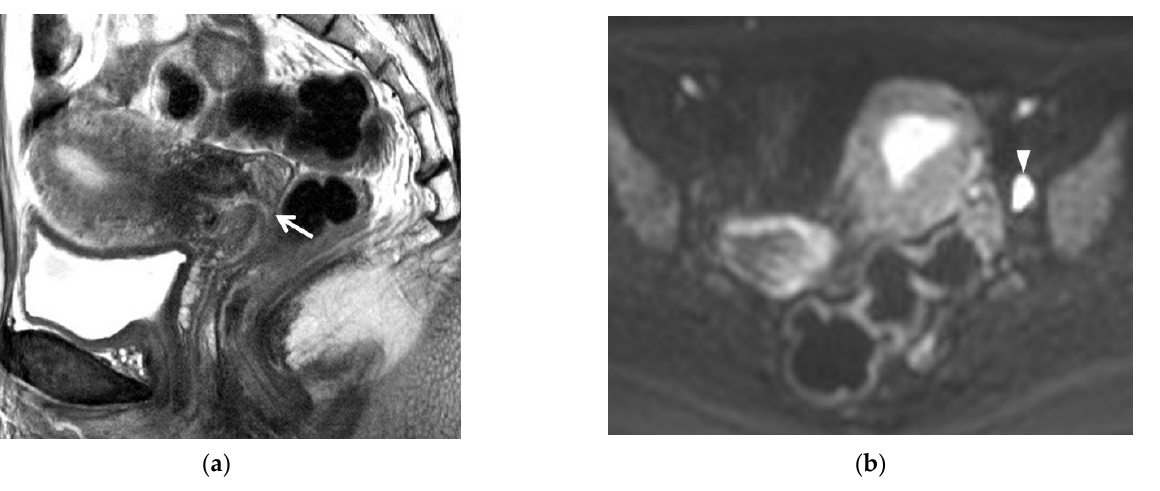
Figure 1. A 45-year-old woman with IB1 cervical cancer: ( a ) the IB1 cervical cancer in the patient undergoing a cone biopsy was not visible on the T2-weighted sagittal image. The arrow indicates the external meatus of the exocervix. ( b ) Diffusion-weighted imaging showed a lymph node (arrowhead) with strong diffusion restriction. No focal lesion was seen in the uterus. Lymph node dissection revealed that the tumor was histologically benign. No parametrial invasion was detected in the radical hysterectomy specimen.